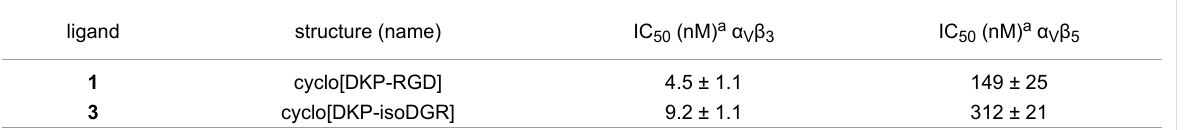
Table 1: Inhibition of biotinylated vitronectin binding to α v β 3 and α v β 5